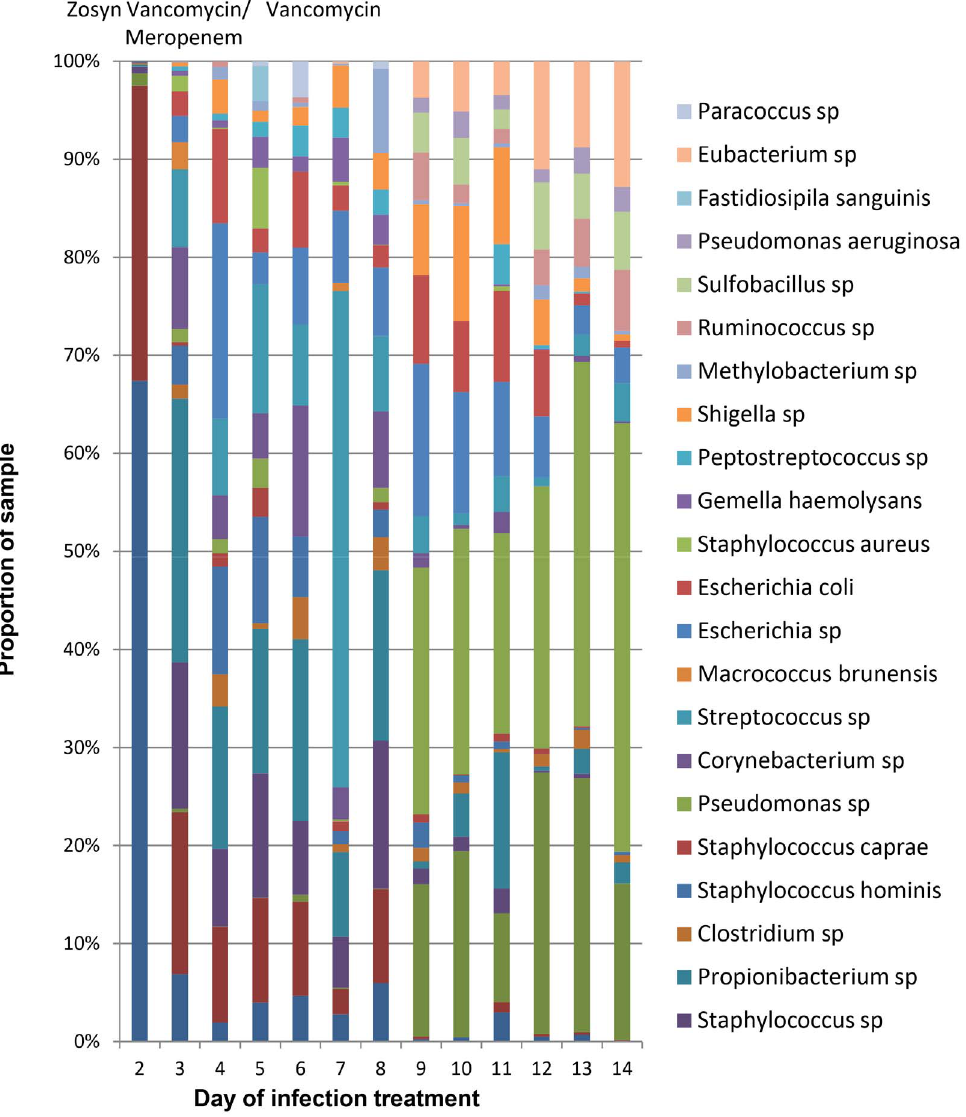
Figure 2. Proportion of bacterial species detected over the course of CSF shunt infection treatment by bTEFAP sequencing. Only bacterial taxa that constitute over 2% of the reads from each sample on any day are shown; fungi are not presented. No bacteria or fungi were detected in either of the two concurrent negative controls (CSF and PBS). The only CSF cultures that grew organisms was that collected on day 2, which grew Staphylococcus epidermidis . Surgeries were performed on day 1 (abdominal exploration), day 2 (CSF shunt removal) and day 14 (CSF shunt replacement). Antibiotic treatment provided is shown above the corresponding day it was given; for instance, vancomycin and meropenem were provided on days 2 through